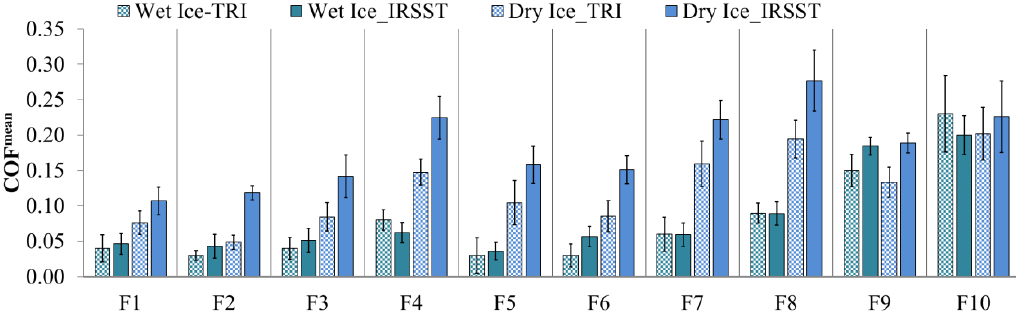
Figure 10. The mean COF values from KITE and IRSST mechanical test on wet and dry ice surfaces.